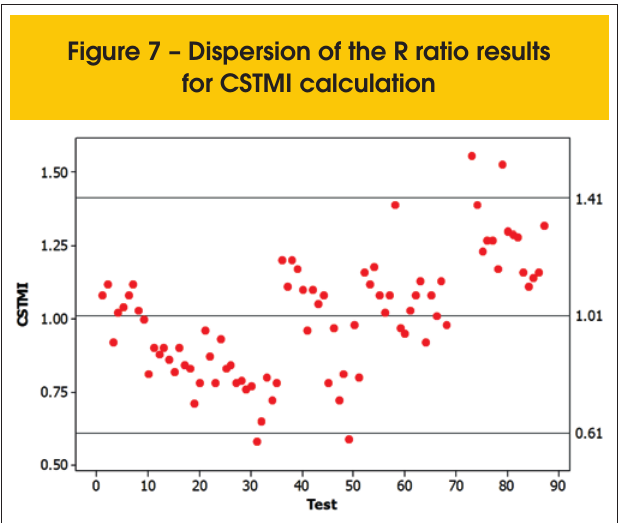
Figure 7 – Dispersion of the R ratio results for CSTMI